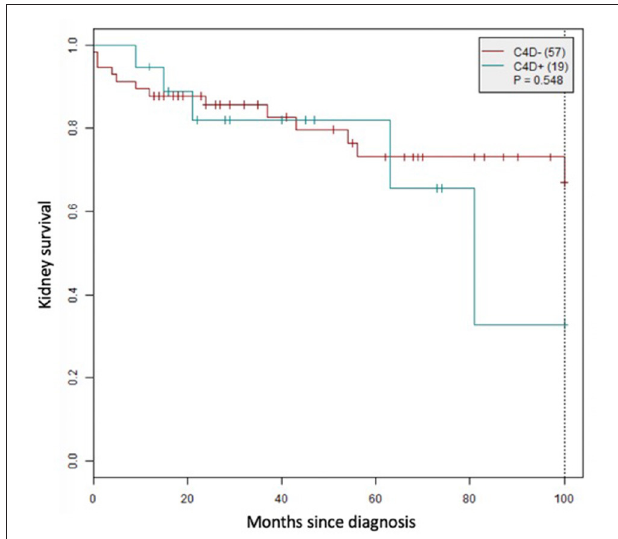
FIGURE 3 | Kidney survival according to glomerular C4d status.